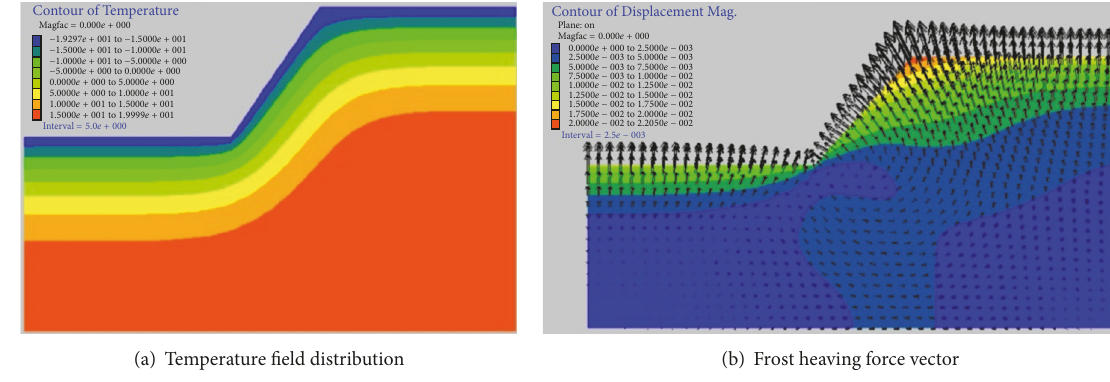
Figure 8: Simulation results of temperature field and frost heaving force for slope. Table 2: The involved parameters used in the numerical simulation model.